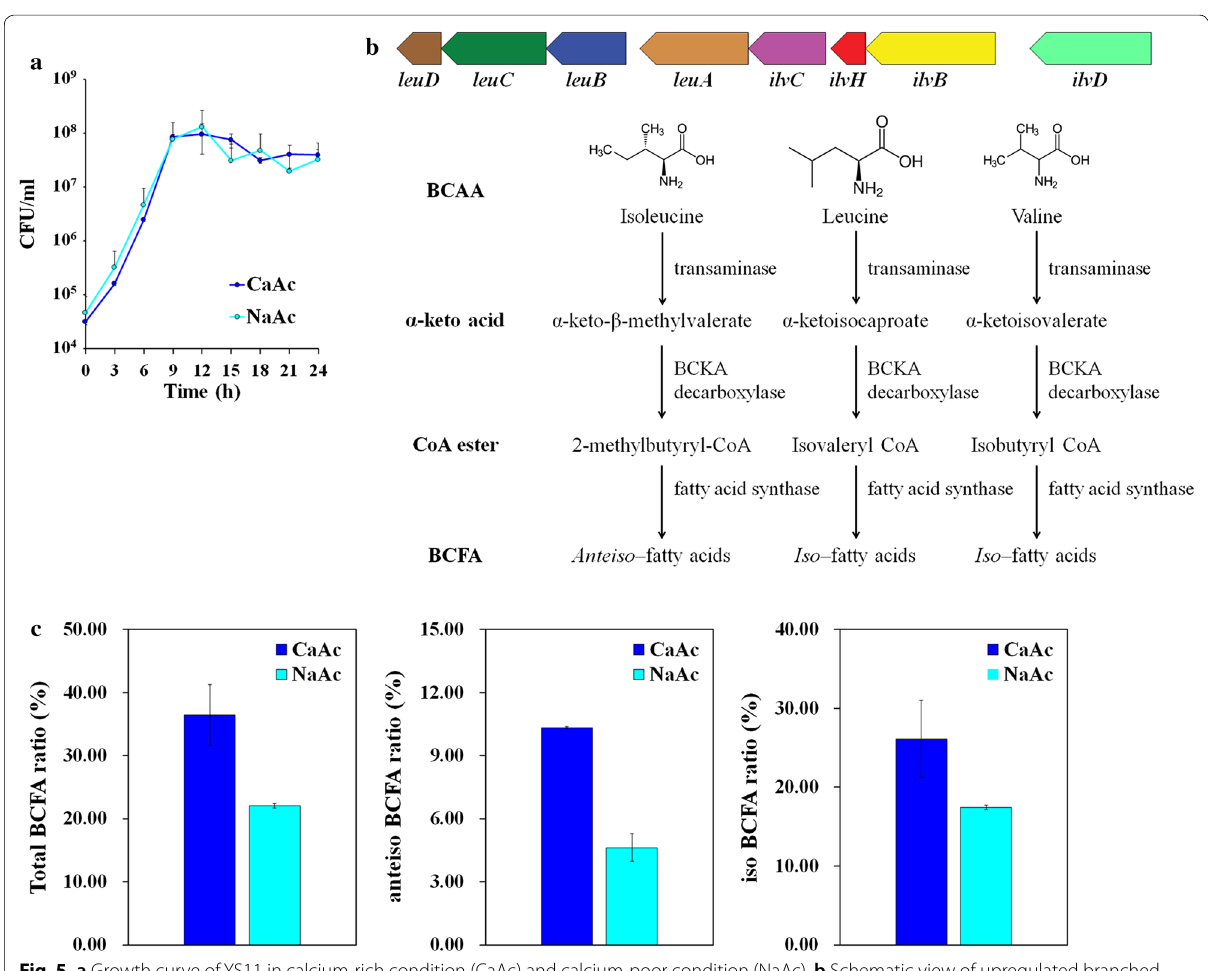
Fig. 5 a Growth curve of YS11 in calcium-rich condition (CaAc) and calcium-poor condition (NaAc). b Schematic view of upregulated branched chain amino acid (BCAA) and branched chain fatty acid (BCFA) synthesis in CaAc. c Modified BCFA ratio in CaAc compared to that in